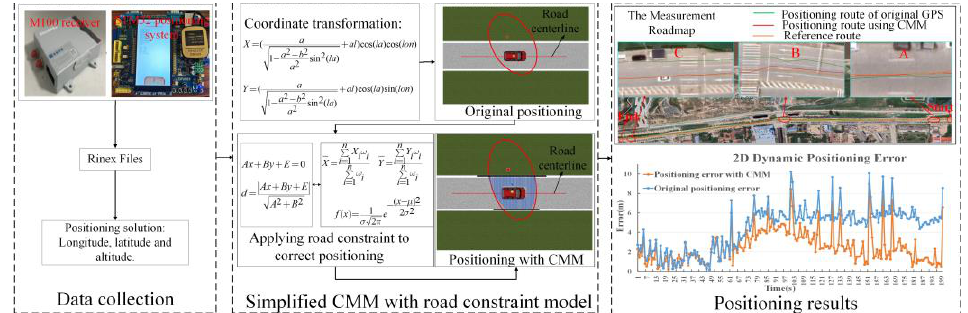
Figure 2. The overall process of CMM correction